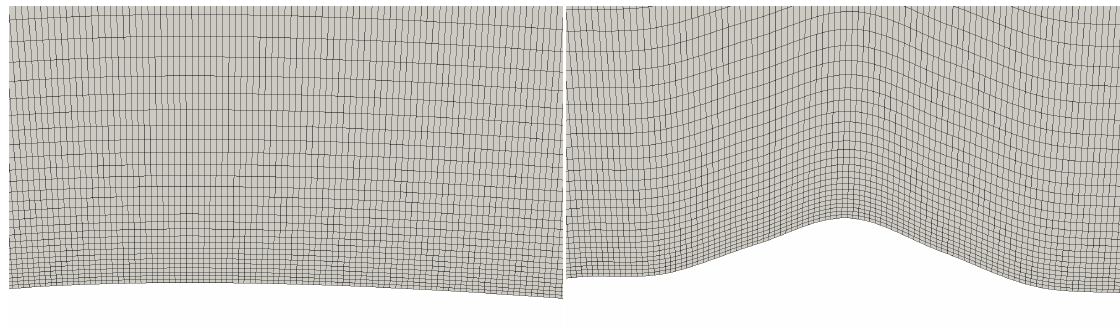
Figure 2. Mesh deformation of the suction side of an